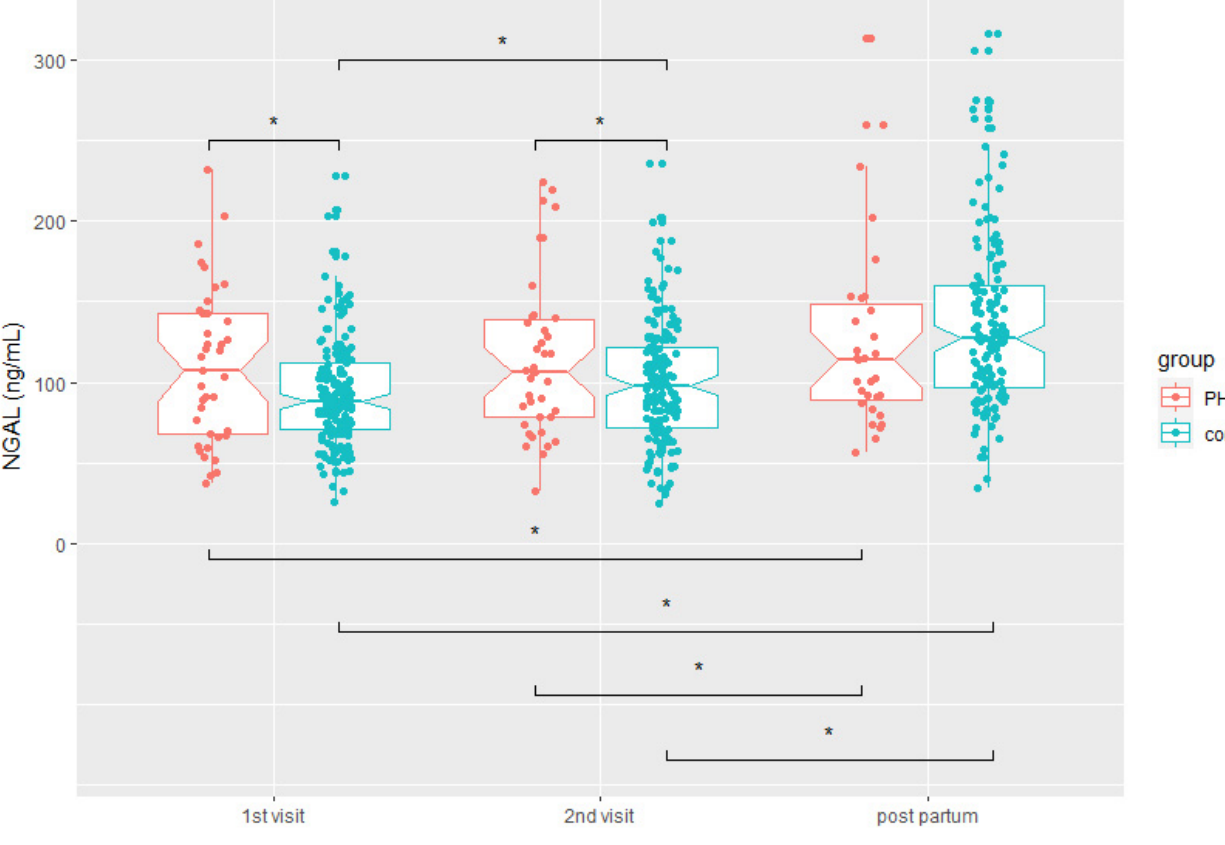
Figure 1. Neutrophil gelatinase ‐ associated lipocalin (NGAL) values at different time points during pregnancy between control ( n = 200) and study group ( n = 42). Median, 95% confidence interval and quartiles are shown. PH, pregnancy hypertension; PE, preeclampsia; ng/mL, nanograms/millilitre. * significant difference ( p ≤ 0.05, by Mann–Whitney ‐ U test). Table 2. Multivariate regression analysis of NGAL values at the first visit ( n = 242).